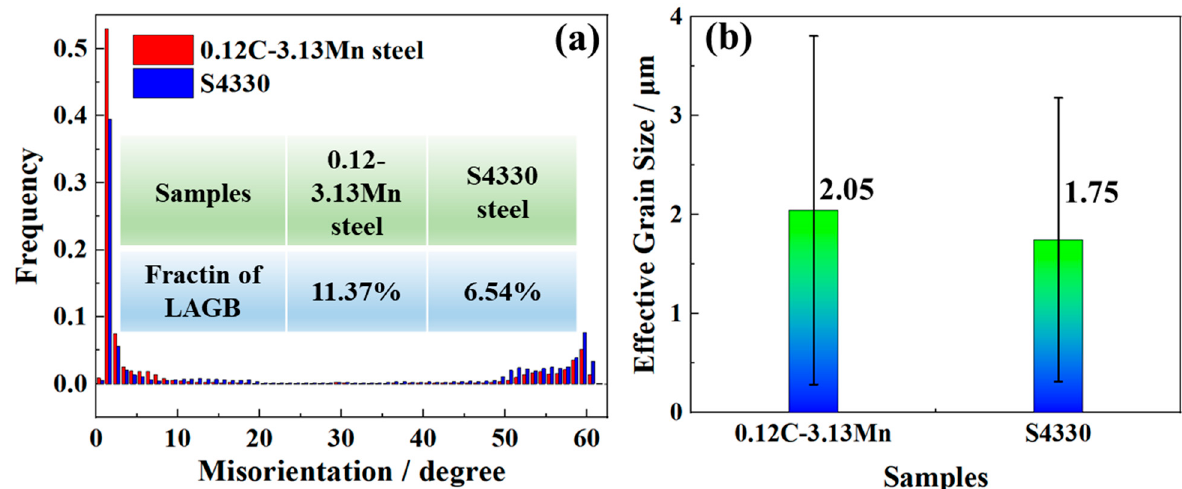
Figure 8. ( a ) Misorientation of 0.12C-3.13Mn steel and S4330 steel; ( b ) effective grain size of 0.12C-3.13Mn steel and S4330 steel.